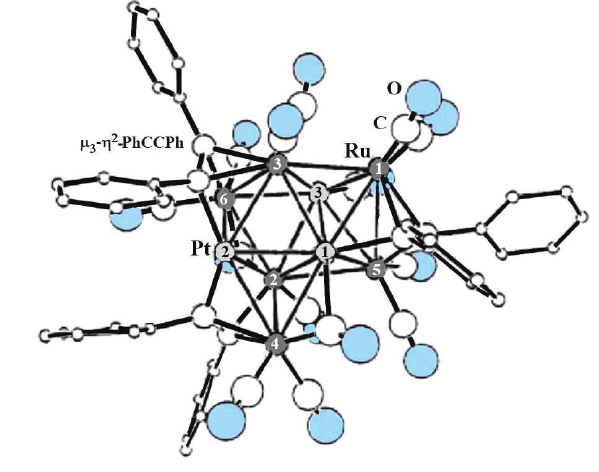
Ru (µ -η 2 -PhC ≡ CPh) 3 6 3